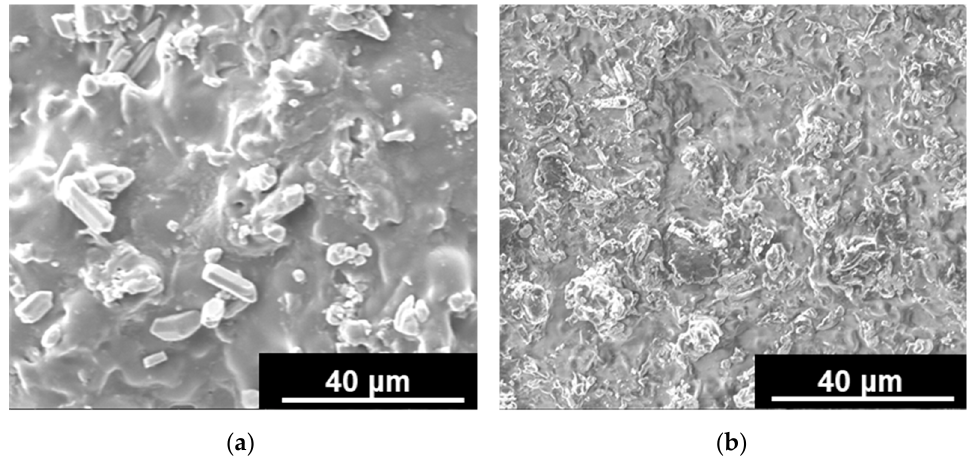
Figure 3. SEM images of ( a ) H P and ( b ) H C showing the GO sheet incorporated into the hybrid materials and emerging from the surface.